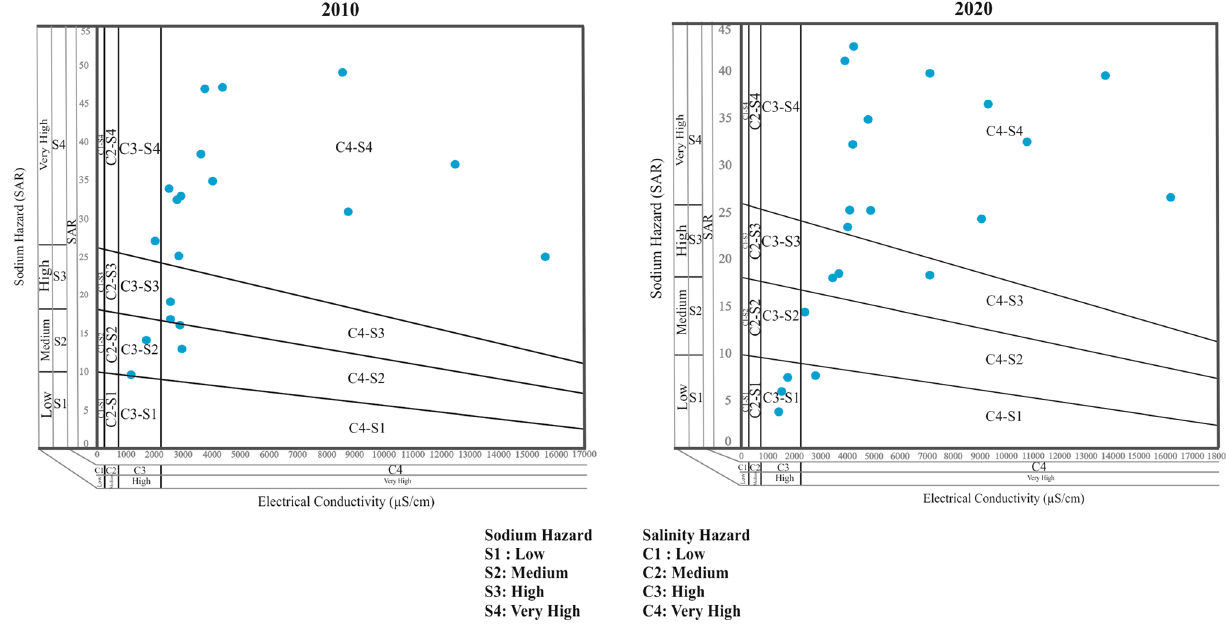
Fig. 8 US salinity diagram (USSL) for classification of irrigation water for the year 2010 and